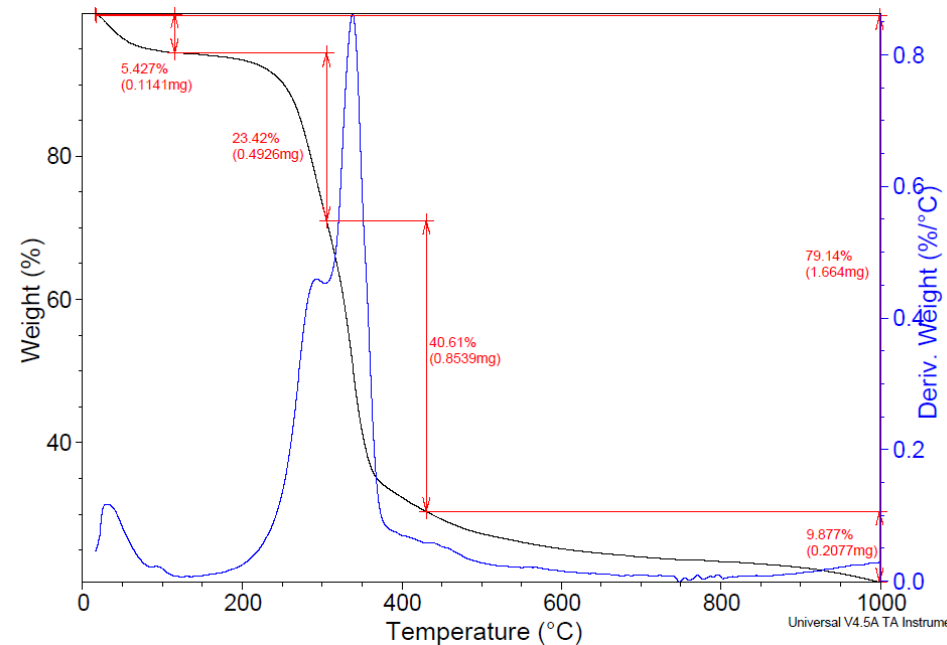
Figure 3. TGA and DTG curves for rice straw.